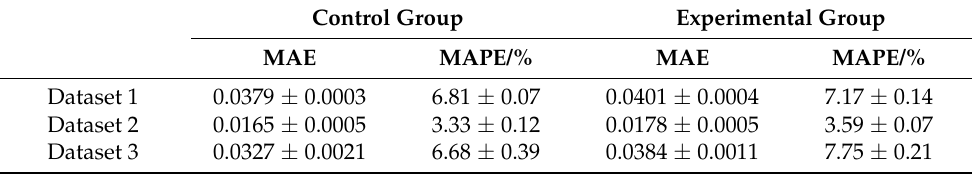
TPA-LSTM Our Model Target Value CNN-LSTM Figure 15. The prediction comparison diagram of differential value.